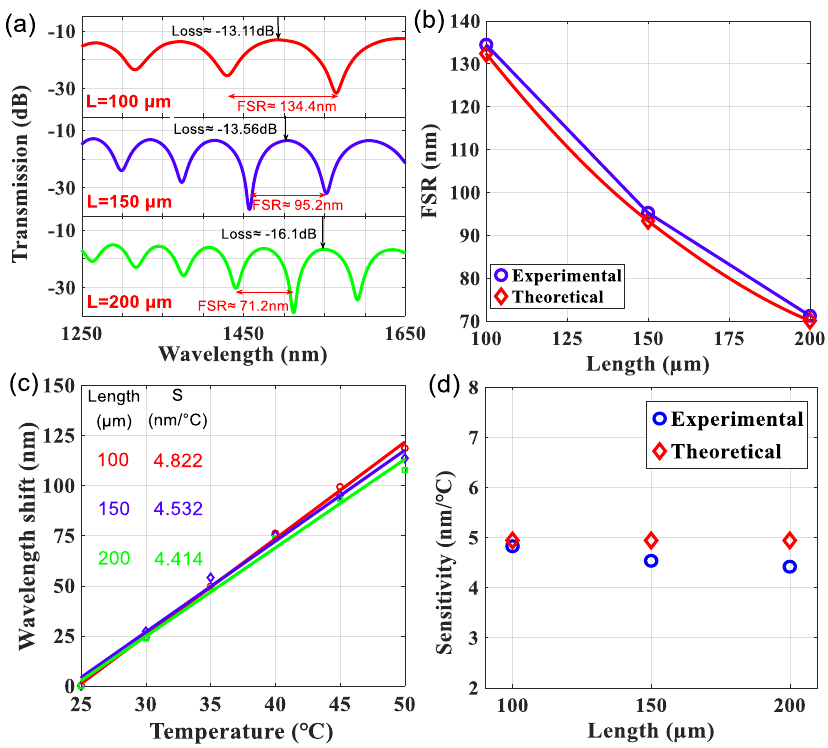
Figure 8. ( a ) Interference spectra, ( b ) theoretical and experimental results of the FSR, ( c ) experimental T-sensitivity, and ( d ) experimental and theoretical T-sensitivity by introducing a Cargille-liquid ( n D ⁡ = 1.305) into the HCF with L~100, 150, and 200 μm.